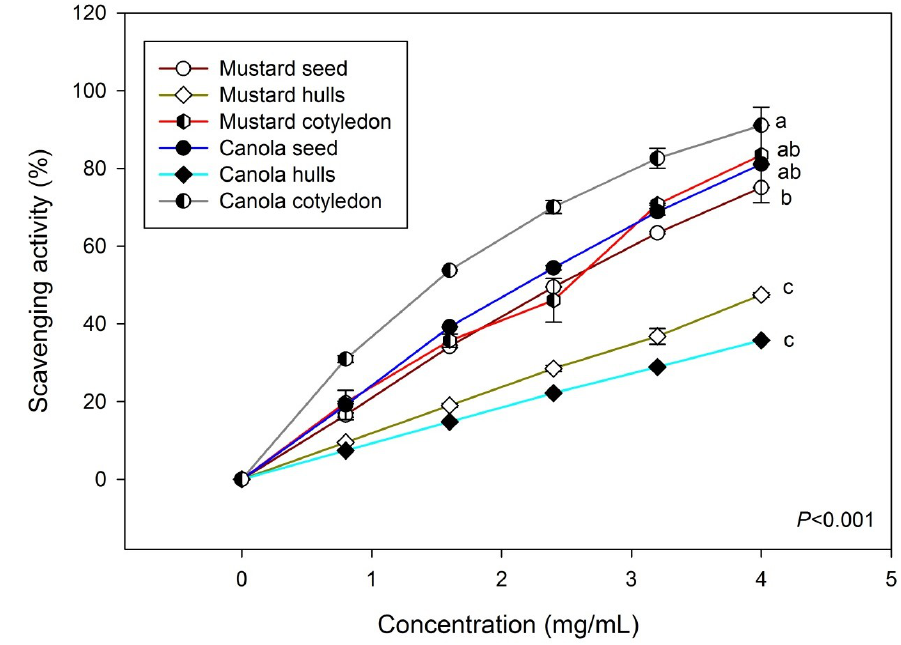
Figure 3. 1,1-diphenyl-2-picrylhydrazyl (DPPH) scavenging activity (%) of phenolic extracts from seeds, cotyledons and hulls of Nexera canola and mustard. (Values with different letters were significantly different at p <